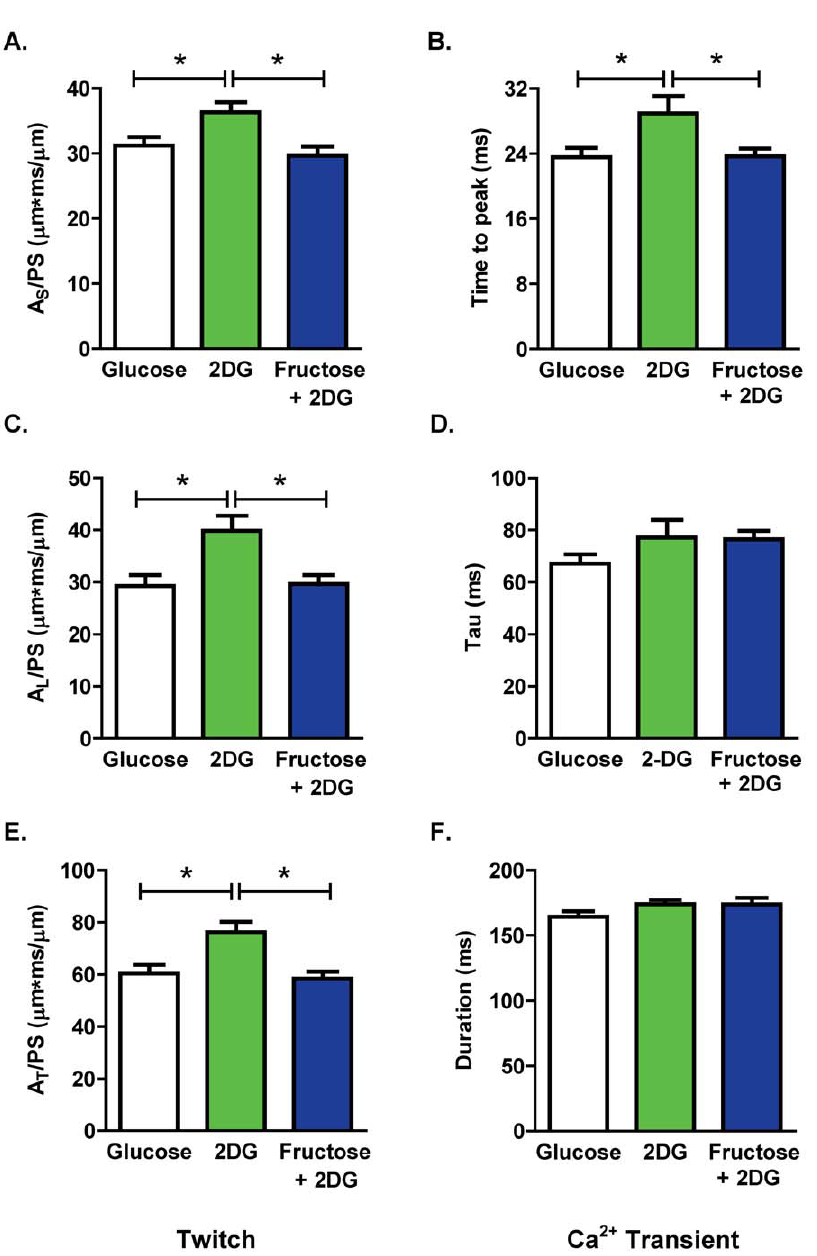
Figure 4. Effect of acute fructose on cardiomyocyte shortening and Ca 2 + handling kinetics. A. Area of the shortening phase of the twitch cycle normalized to peak shortening (A S /PS) B. Time to peak Ca 2 + transient relative to electrical stimulus. C. Area of the lengthening phase of the twitch cycle normalized to peak shortening (A L /PS). D. Time constant of Ca 2 + transient decay (Tau). E. Area of the total twitch cycle normalized to peak shortening (A T /PS). F. Duration of the Ca 2 + transient (time from stimulus to 90% Ca 2 + transient decay). Data presented as mean 6 s.e.m. n=10– 28 cells/group. *p , 0.05 (1-way ANOVA, Newman-Keuls post-hoc